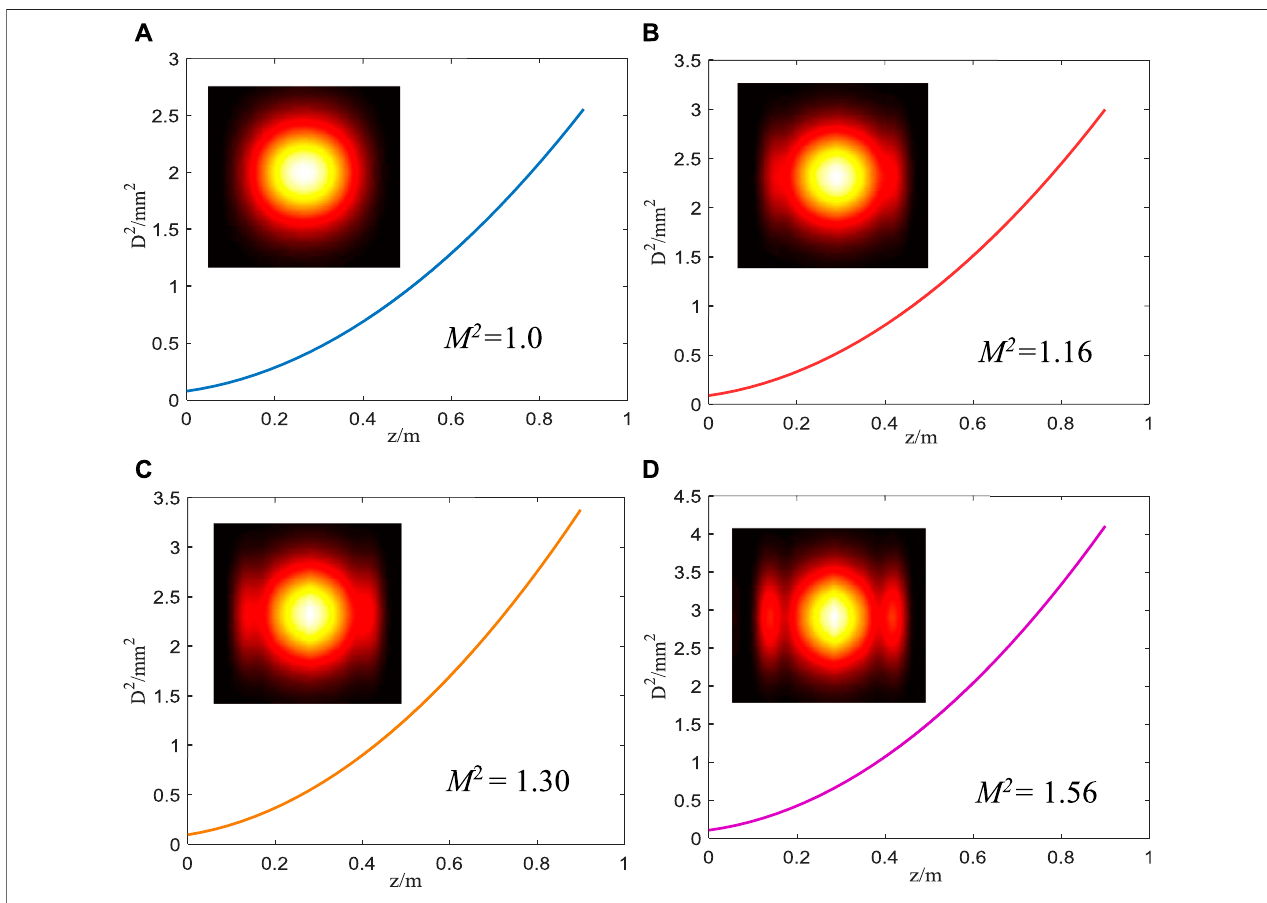
FIGURE 12 | The intensity distributions and the curves of M 2 of the combined beams (A) without deformation; (B) 10, (C) 30, and (D) 60 s.